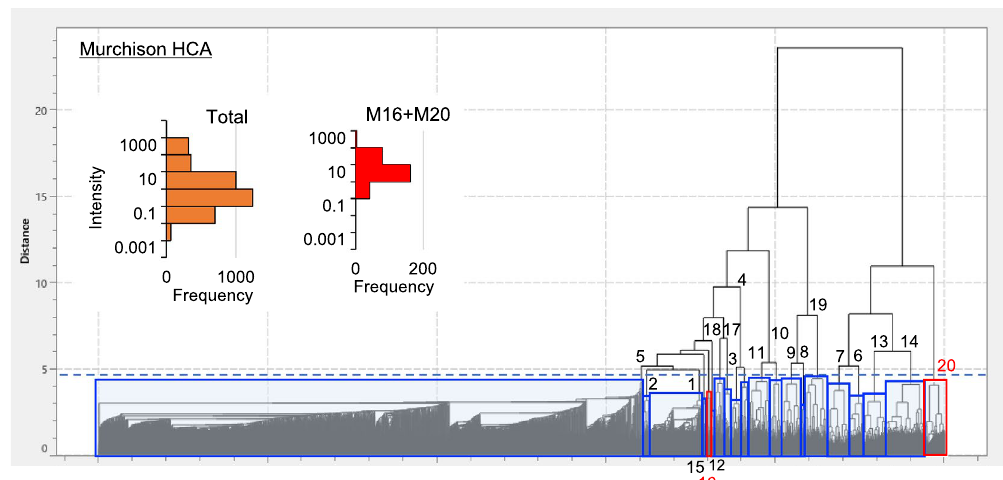
Figure 4. Hierarchical cluster analysis of major signals detected in the Murchison meteorite. The relative dissimilarity of spatial distributions between the clusters is represented by the distance of the horizontal bar between the clusters. The signals in clusters M16 and M20 correspond to the signals in cluster N16 of the NWA801 but are divided into M16 and M20 in this